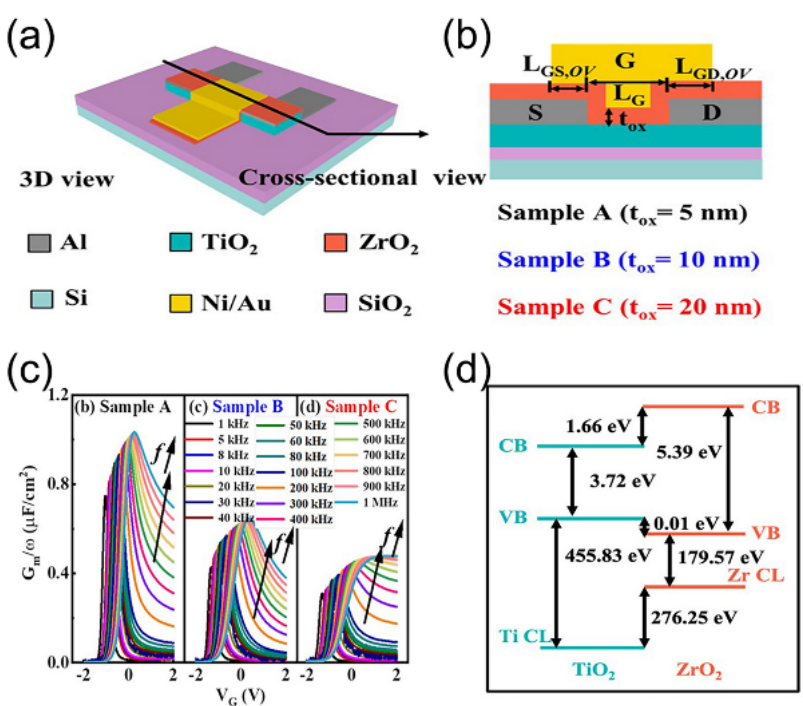
Figure 9. A TiO 2 TFT with the same device size and different ZrO 2 dielectric layer thickness in stereoscopic view ( a ) and cross-sectional view ( b ). ( c ) Equivalent parallel conductance ( G / ω ) measured for samples A, B and C as a function of applied voltage. ( d ) Derived band alignment of ZrO 2 /TiO 2 from X-ray photoelectron spectroscopy (XPS) results. Reproduced with permission from Ref. [59]; published by the American Chemical Society, 2021.